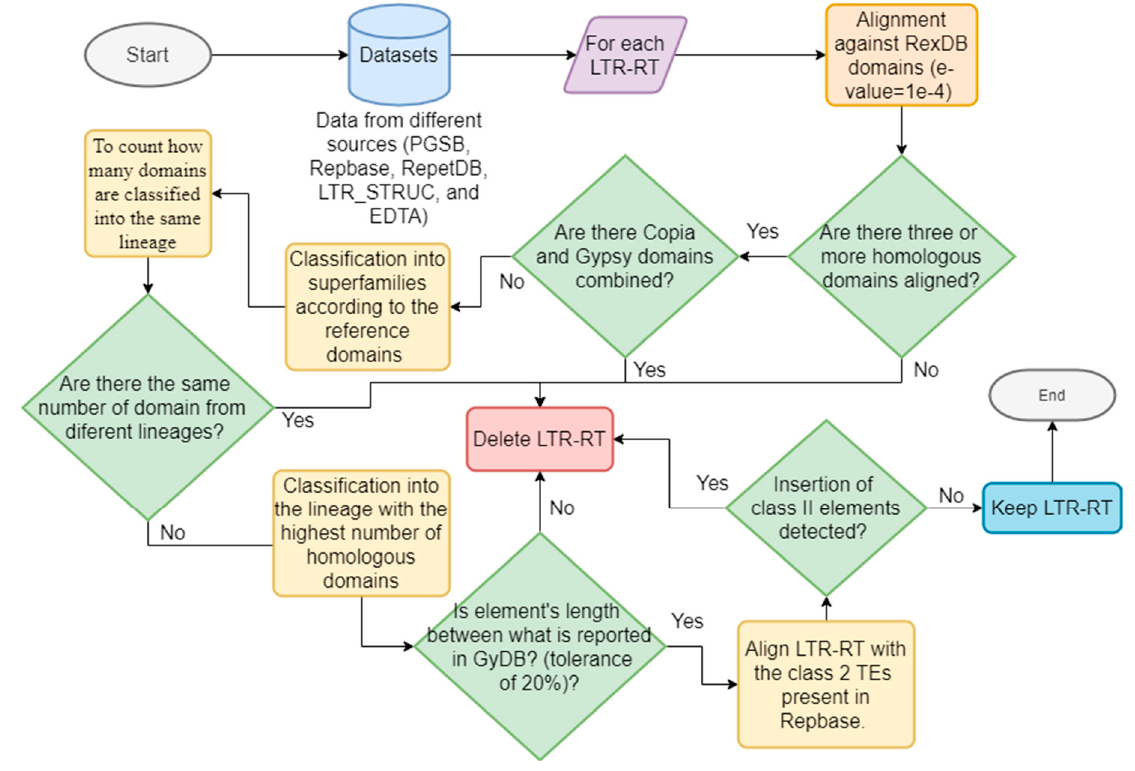
Figure 1. Schematic representation of the classification and filtering process performed for InpactorDB. The data generated is available at Zenodo under doi:10.5281/zenodo.4453481 and at DataSuds (https://dataverse.ird.fr) under doi:10.23708/QCMOUA.